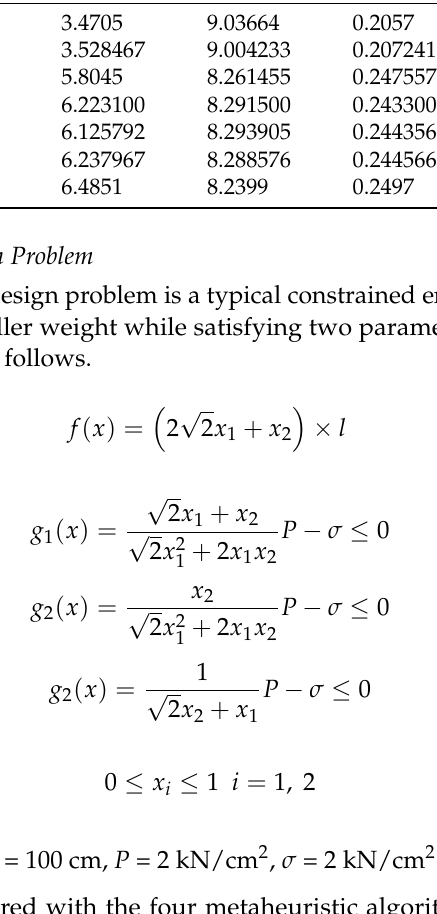
Table 15. Comparison results of the welded beam design problem.